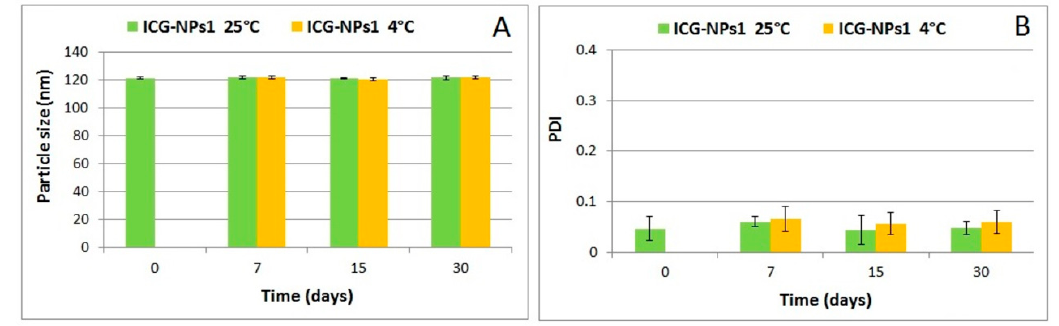
Figure 1. Physical stability of ICG-NPs1 in terms of particle size ( A ) and PDI ( B ).